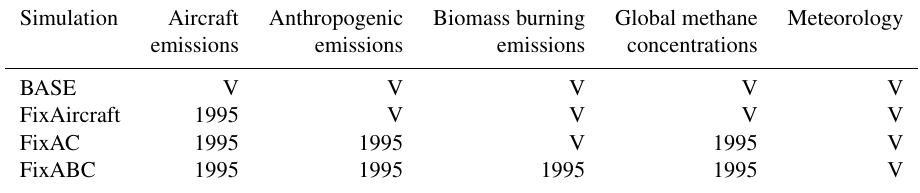
Table 2. Configurations of GEOS-Chem simulations in this study ∗ .